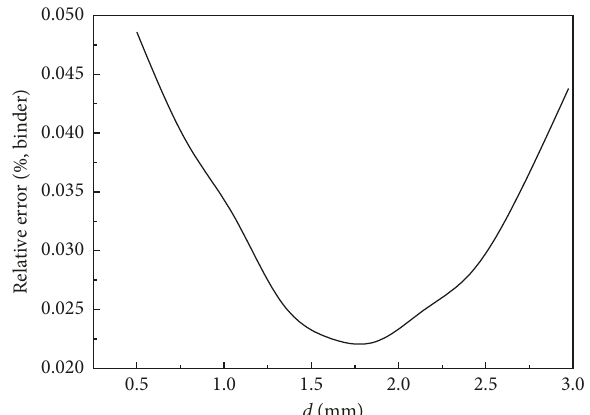
Figure 9: Variation of relative error with the width of the virtual boundary.